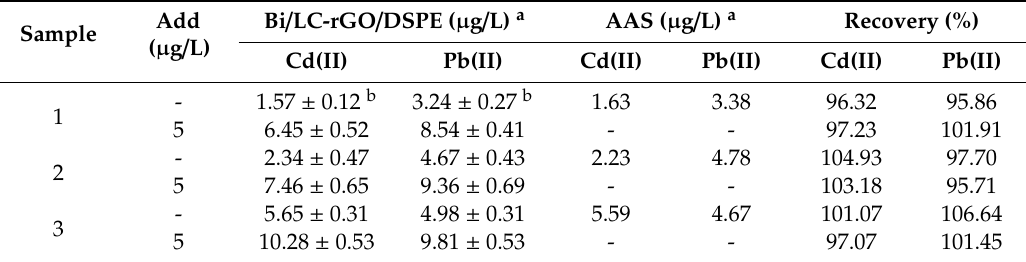
Table 2. Results for the determination of Cd(II) and Pb(II) in the extracted solutions. Sample